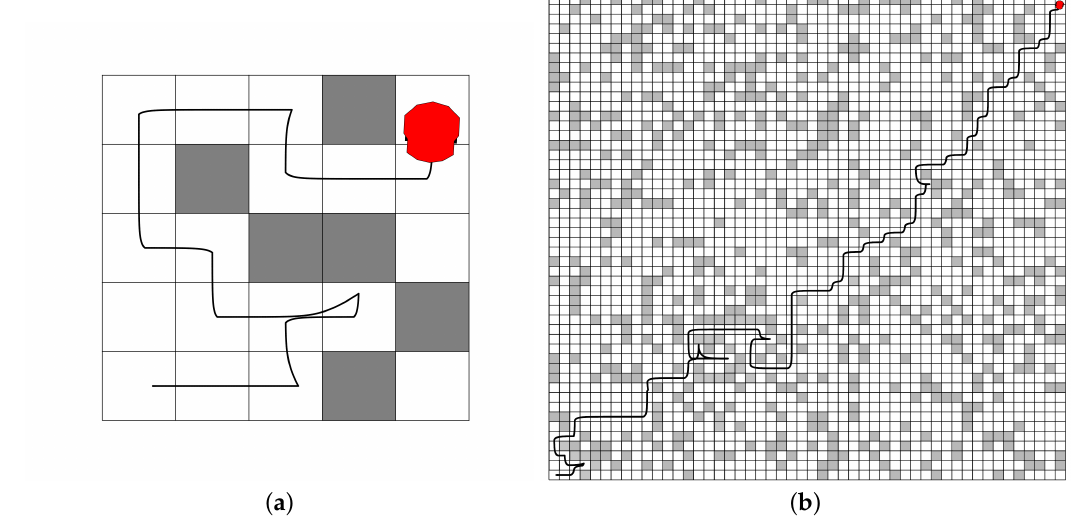
Figure 6. Simulation to check the computational cost for the code in ( a ) a 5 × 5 grid and ( b ) a 50 × 50 grid.